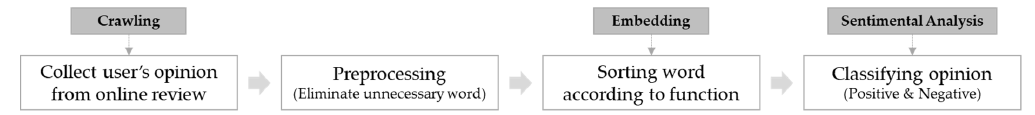
Figure 3. Overview of online review analyzing process.